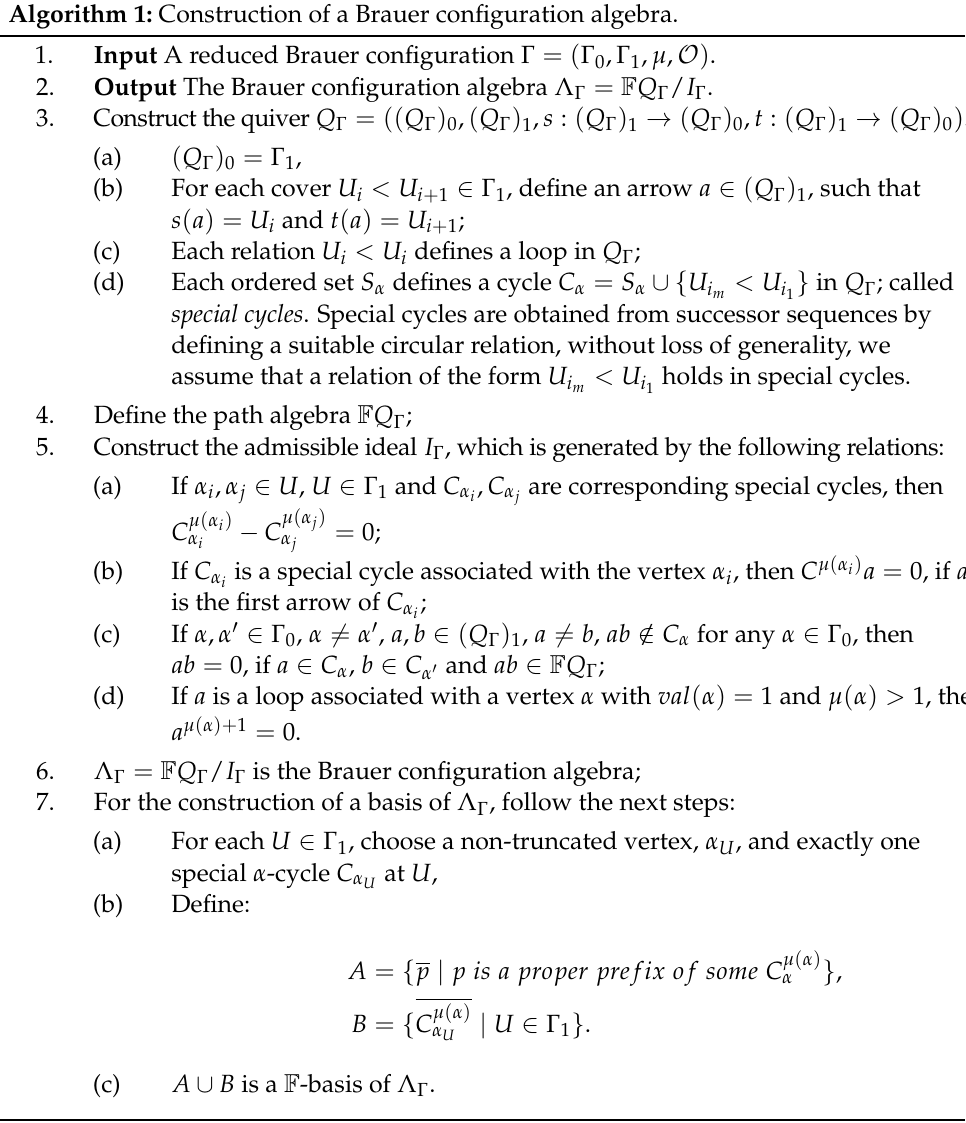
Algorithm 1: Construction of a Brauer configuration